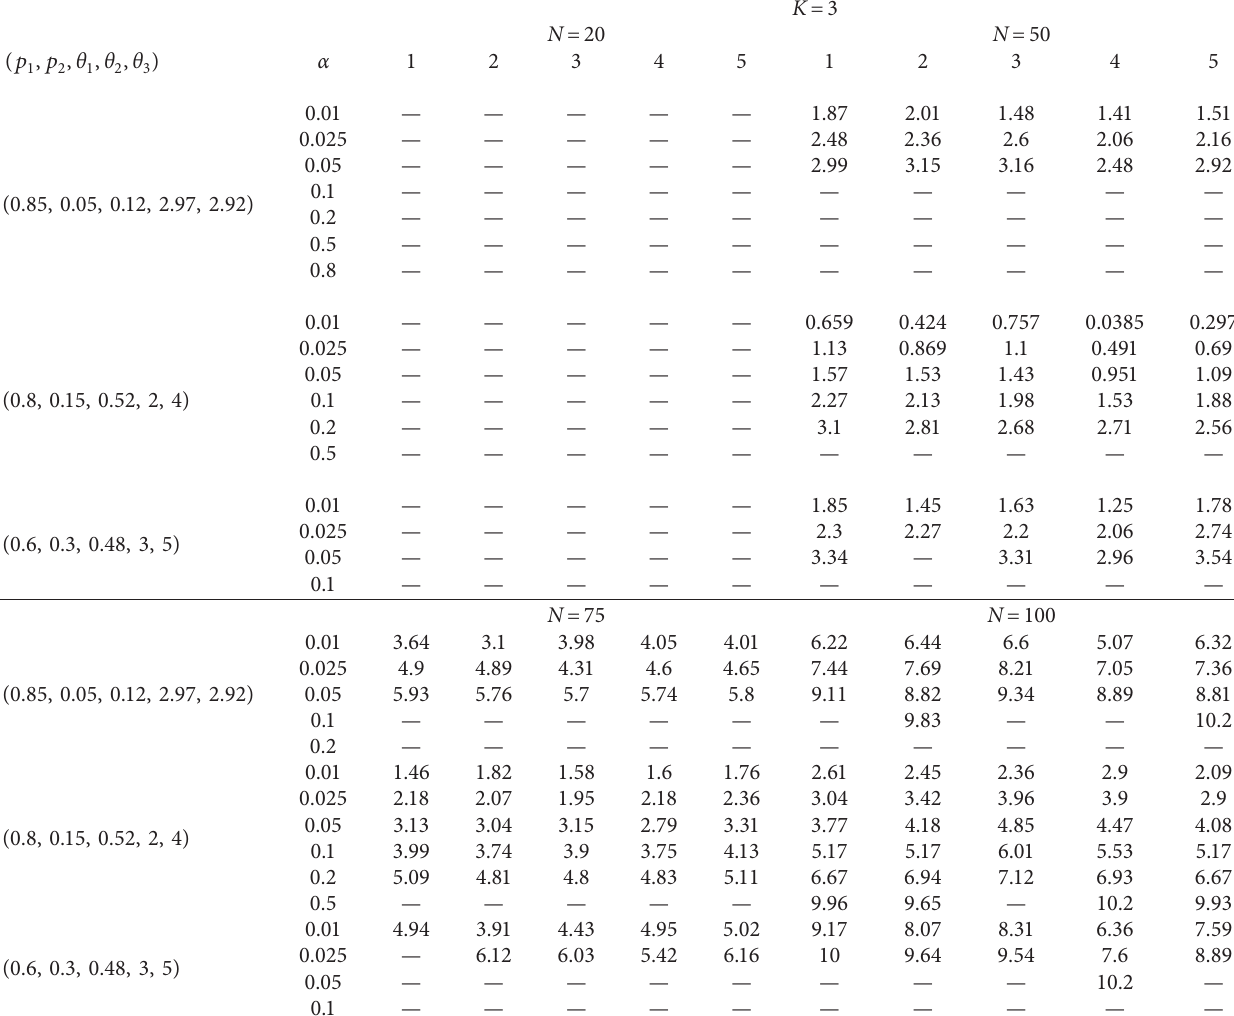
Table 2: Quantiles for estimated number of finite exponential components at k �